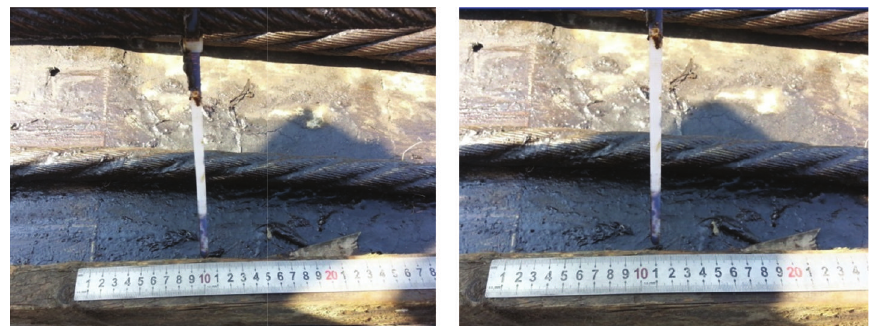
Figure 10: The result of wire rope draw-in at 0.01m.